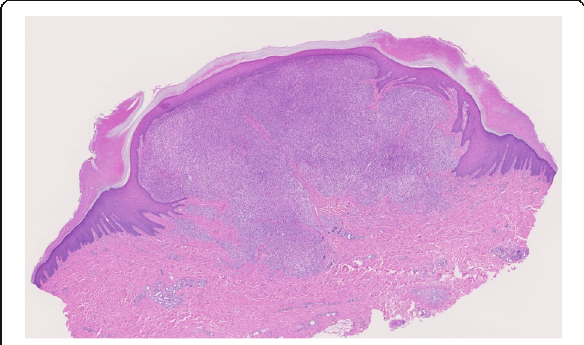
Fig. 2 A low-power microscopic view of the lesion revealing a nodular, dermal-based tumor surrounded by an epidermal collarette